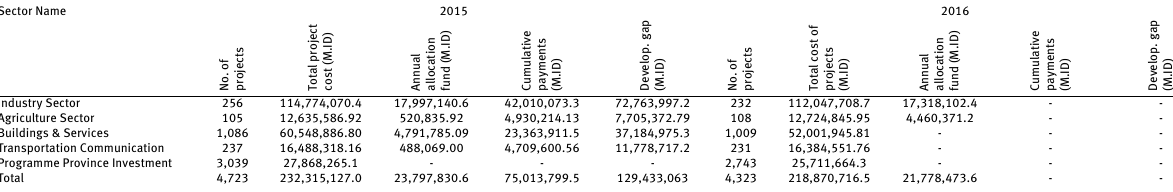
Table 1B: Situations of Investment Plan Projects for (2015–2018)* SectorName